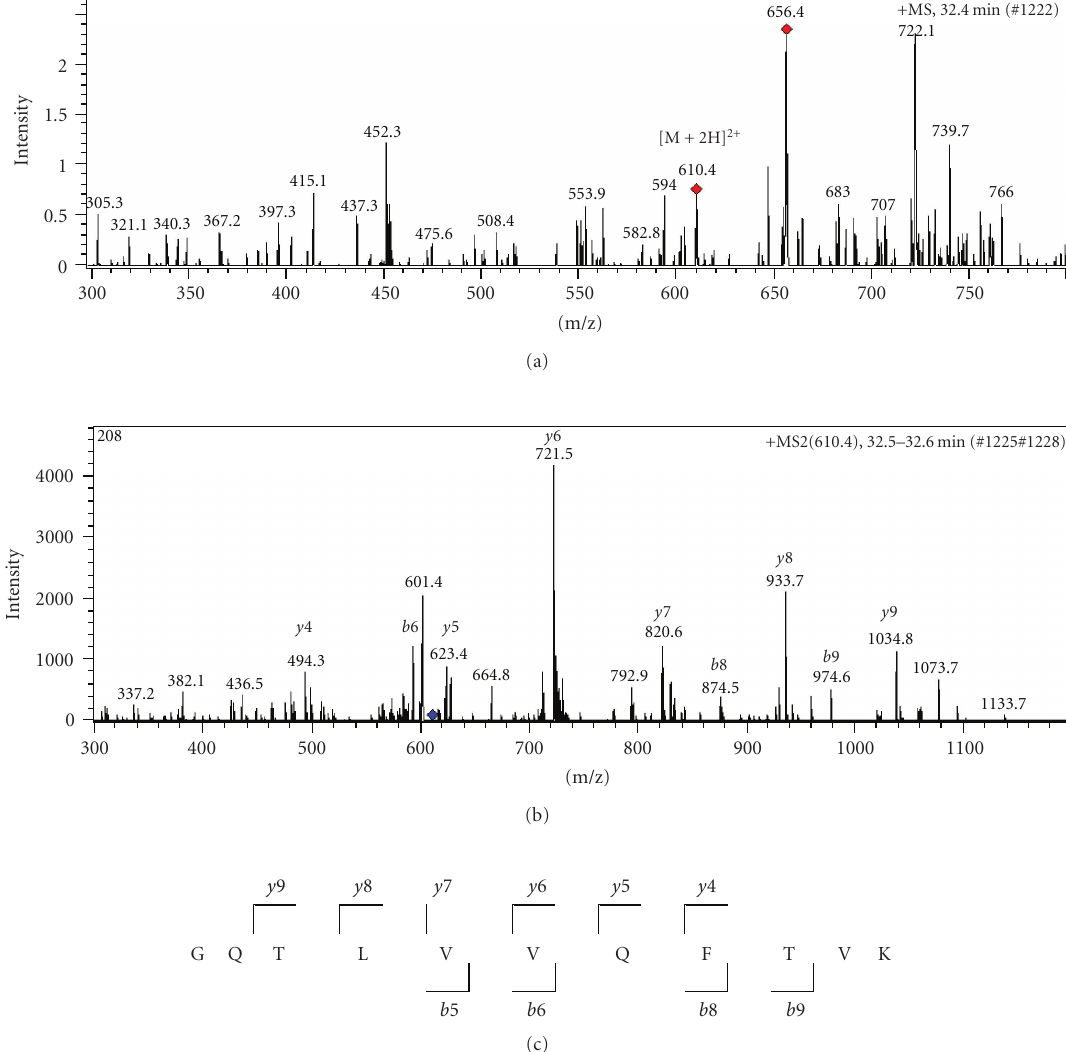
Figure 3: Identification of protein. (a) Full scan MS spectrum of peptide eluted out at 32.4 minutes. (b) MS/MS spectrum of 610.4 product ions. (c) Amino acid sequence of peptide eluted out 32.4